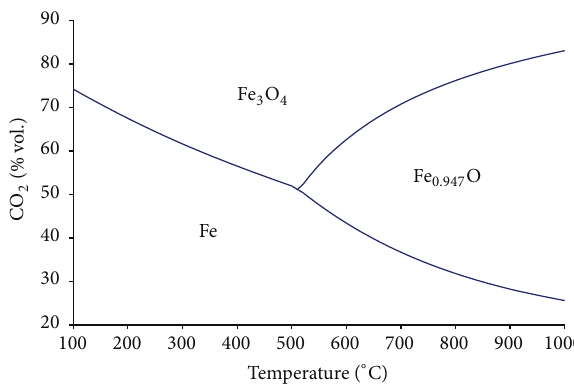
Figure 3: The phase stability diagram of Fe, Fe 0.947 O, and Fe 3 O 4 phases in CO-CO 2